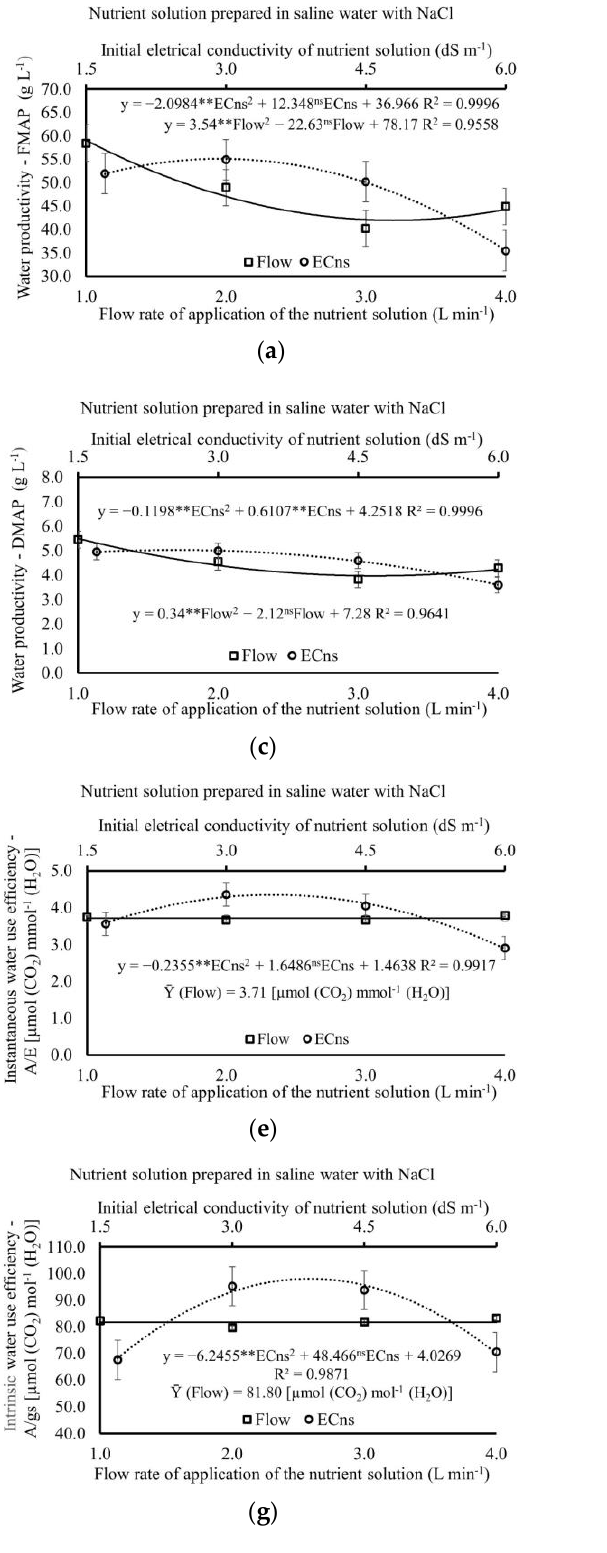
Figure 7. Water productivity, based on fresh ( a , b ) and dry ( c , d ) mass shoots; instantaneous efficiency — A/E ( e , f ) and intrinsic — A/gs ( g , h ) of water use of coriander plants, cv. Verdão, exposed to nutrient solutions prepared in brackish water, salinized with NaCl and CaCl 2 ·2H 2 O; it was applied in crescents flow rates.